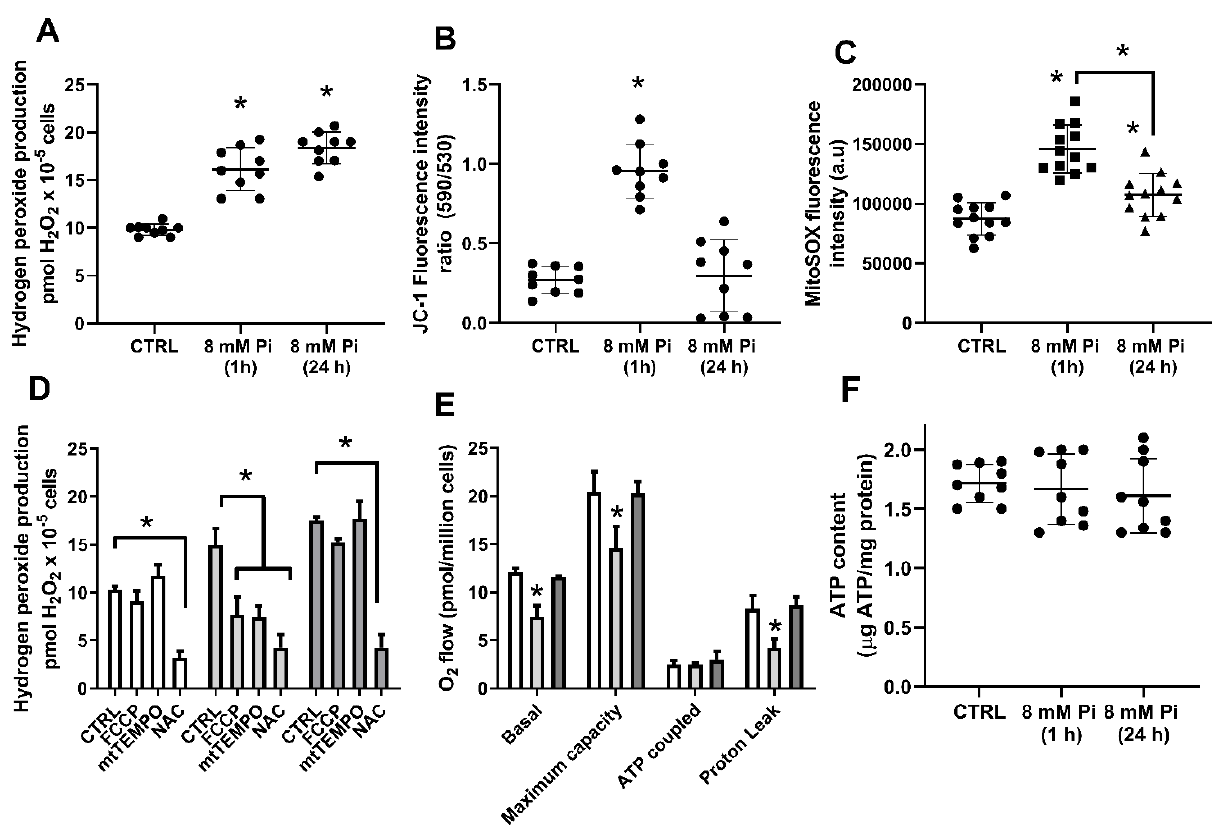
Figure 6. The H 2 O 2 production source for short Pi-exposure in MDA-MB-231 cells. MDA-MB-231 cells were treated with 1 mM (CTRL) or 8 mM Pi for 1 h or 24 h. H 2 O 2 production was evaluated for 1 h at 25 °C using Amplex Red ( A ), ΔΨ m was measured with fluorescence dye JC-1 at room temperature ( B ) and mitochondrial ROS (superoxide generation) was measured using mitoSOX assay at 25 °C ( C ). MDA-MB-231 cells were treated with 1 mM Pi (white bars), 8 mM Pi for 1 h (light grey bars) or 8 mM Pi for 24 h (dark grey bars), H 2 O 2 production was evaluated for 1 h in the presence of FCCP (1 μ M), mitoTEMPO (100 nM) or NAC (5 mM) ( D ). MDA-MB-231 cells were treated with 1 mM Pi (white bars), 8 mM Pi for 1 h (light grey bars) or 8 mM Pi for 24 h (dark grey bars) and oxygen consumption was measured at basal levels, maximum capacity (1 μ M FCCP), ATP coupled (basal levels of oxygen consumption minus values in the presence of 2.6 nM oligomycin) and proton leak (2.6 nM oligomycin) ( E ). ATP content was evaluated in MDA-MB-231 cells treated with 1 mM Pi (CTRL) or 8 mM Pi for 1 h and 24 h as indicated ( F ). Results represent mean ± SE of at least 3 independent biological samples. * p < 0.05 indicates changes significantly different, as assessed by ANOVA followed by Tukey’s multiple comparison test.